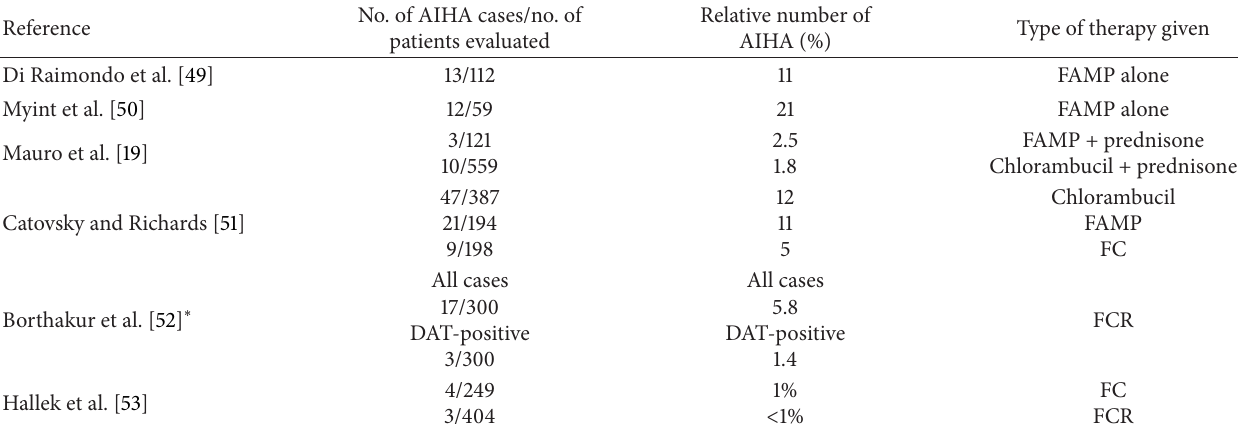
Table 4: Reported incidence of AIHA in fludarabine containing regimen treated patients with CLL.